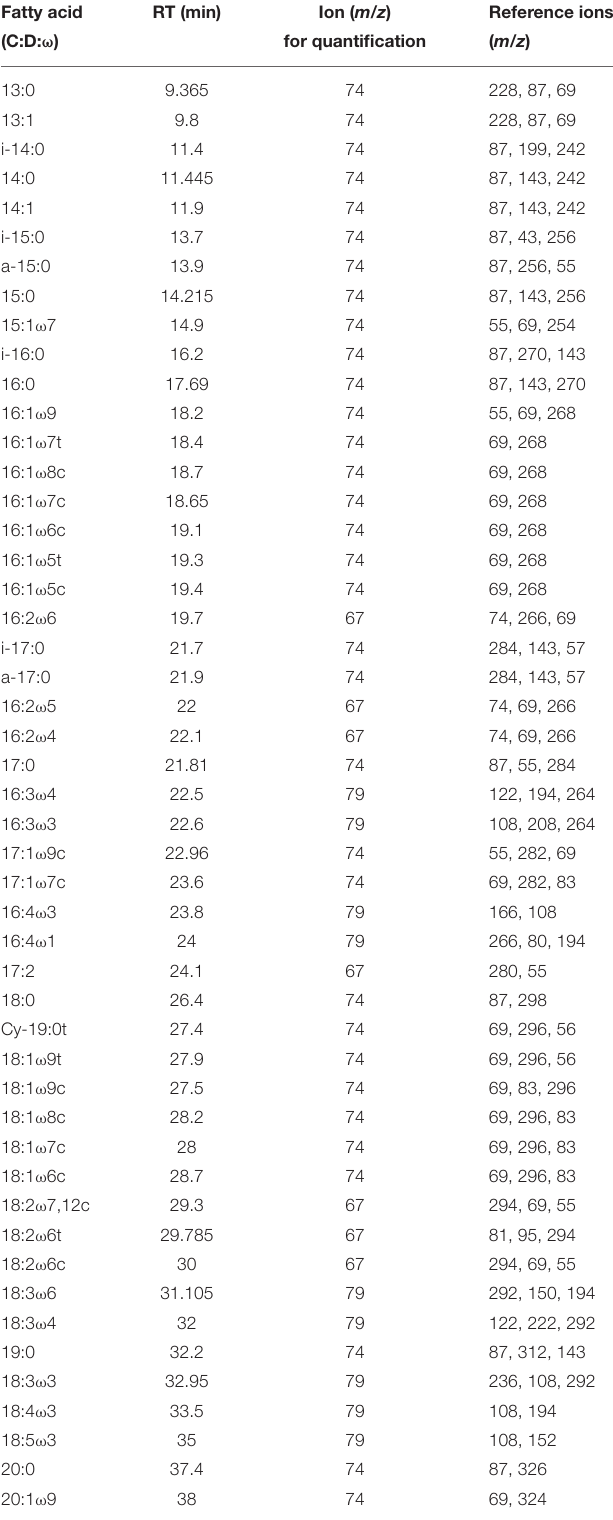
TABLE 2 | Summary of fatty acids analyzed from phytoplankton using the GC-MS method described in the methods section. Fatty acid RT (min) Ion ( m/z ) Reference